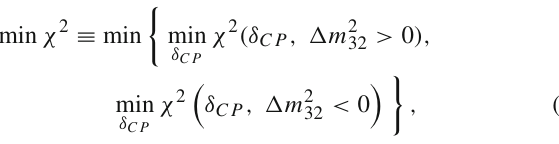
toratOki,respectively.Forcomparativestudy,weshowinthelower-left a subplot for a plan of the T2HK plus a 10 kton water Cerenkov detector at Kamioka. min χ 2 = 1 , 4 , 9 on the red solid, blue dashed, and purple dot-dashed contours,